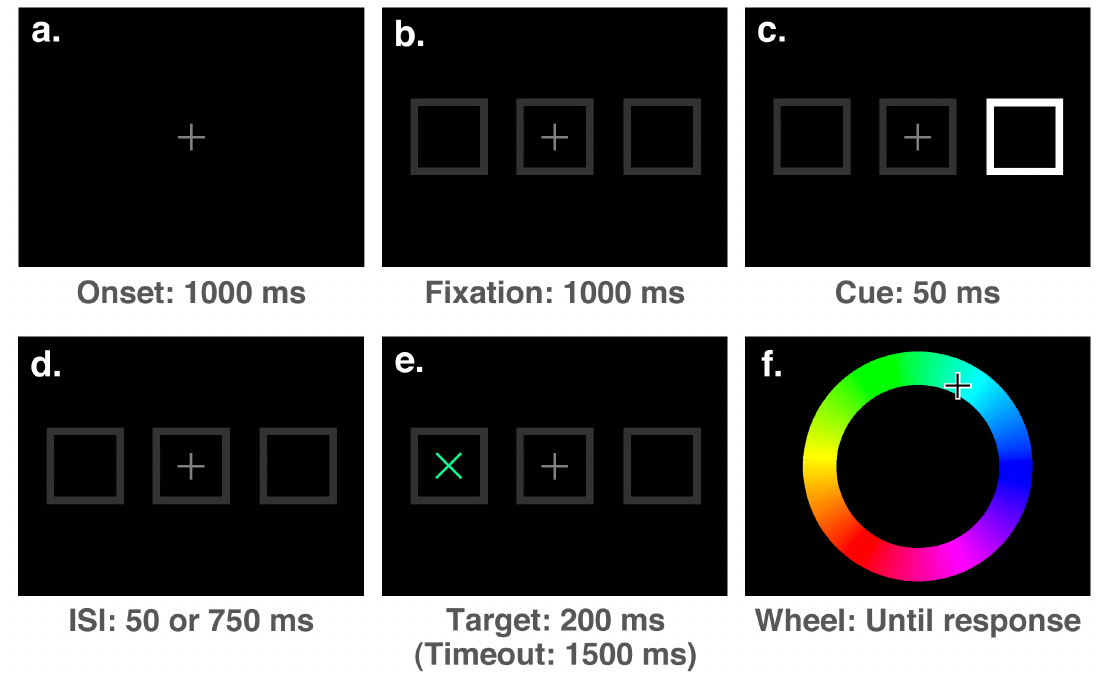
Figure 6. The sequence of events on a single trial for Experiment 2. The sequence is indicated by the letters in the top-left corners of the boxes, and show the stimuli presented during an invalidly cued trial. For the purpose of illustration, stimuli are not drawn to